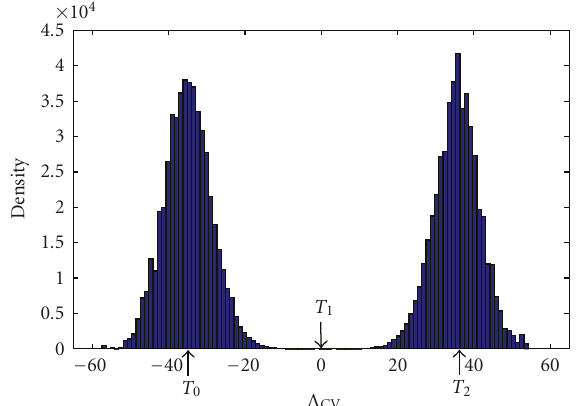
Figure 6: Simulated probability mass function (PMF) of Λ CV2 considering P ( H = 0) = P ( H = 1) .